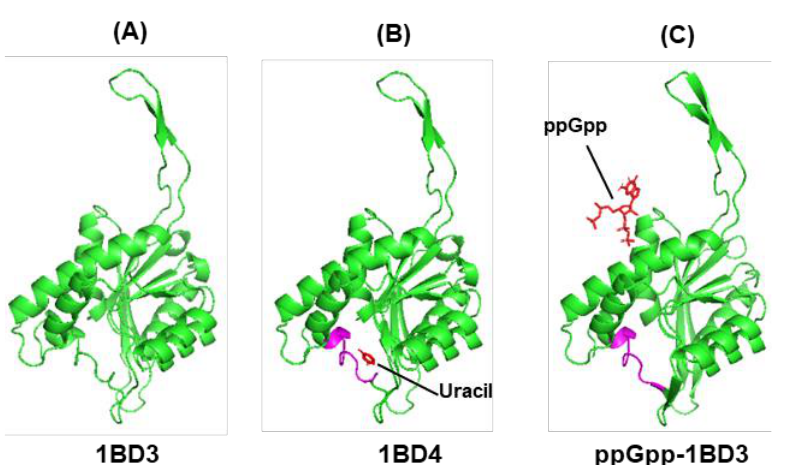
Figure 6. In silico docking of ppGpp to UPRT. The crystal structures of the apo enzyme ( A ) and its complex with uracil, the substrate ( B ), are, respectively, PDB 1BD3 and PDB 1BD4, as shown. The in silico docked co-complex of 1BD3 and ppGpp ( C ) show the significant difference in binding sites of the two ligands (both in red color). The pink segment, spanning a loop and a short helix, represent a region that was considered important for interaction with uracil [128–130]. Structure-blind docking was performed by CB-Dock2 (Supplementary material) as described earlier.